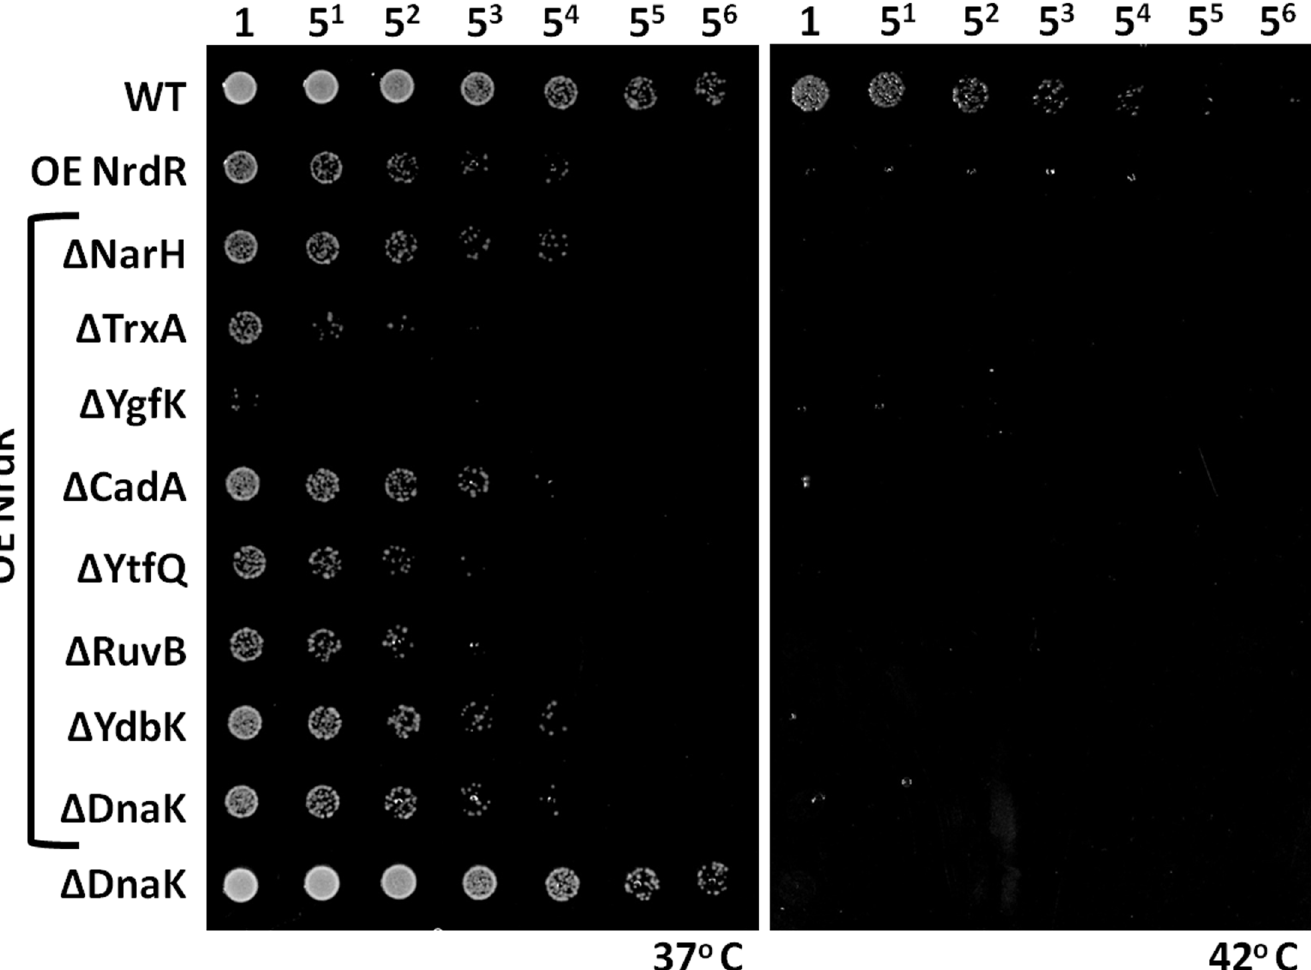
Fig 7. Deletion of downregulated genes upon NrdR overexpression further inhibits bacterial fitness. The highly downregulated non-essential genes NarH, TrxA, YgfK, CadA, YtfQ, RuvB and YdbK were deleted and the corresponding bacterial fitness was studied under the NrdR overexpression background. Deletion of TrxA or YgfK with NrdR overexpression further reduced bacterial fitness compared with NrdR overexpression alone. Deletion of NarH, CadA or YdbK did not result in enhanced reductions in bacterial fitness. Fitness deterioration was not enhanced even with the deletion of YtfQ and RuvB, key genes in DNA damage response. Empty vectors of pET-duet (Kan + ) and pCA24N (Cam + ) were transformed into WT strains as control. The Δ DnaK E . coli strain was used both as negative and positive controls by excluding or incorporating NrdR overexpression, respectively. Dilution factors for the E . coli cultures are labeled over the